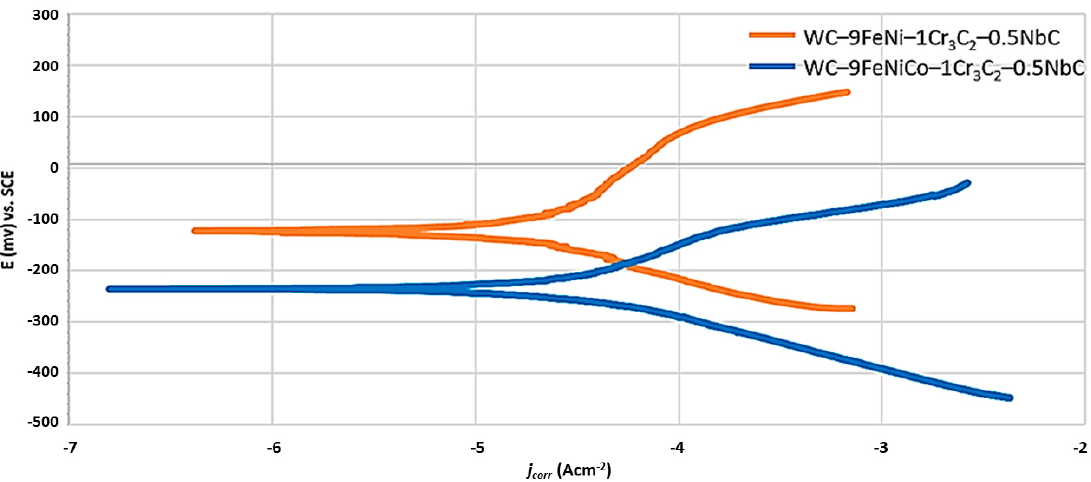
Figure 8. Potentiodynamic polarization curves (Tafel extrapolation diagram) of samples.